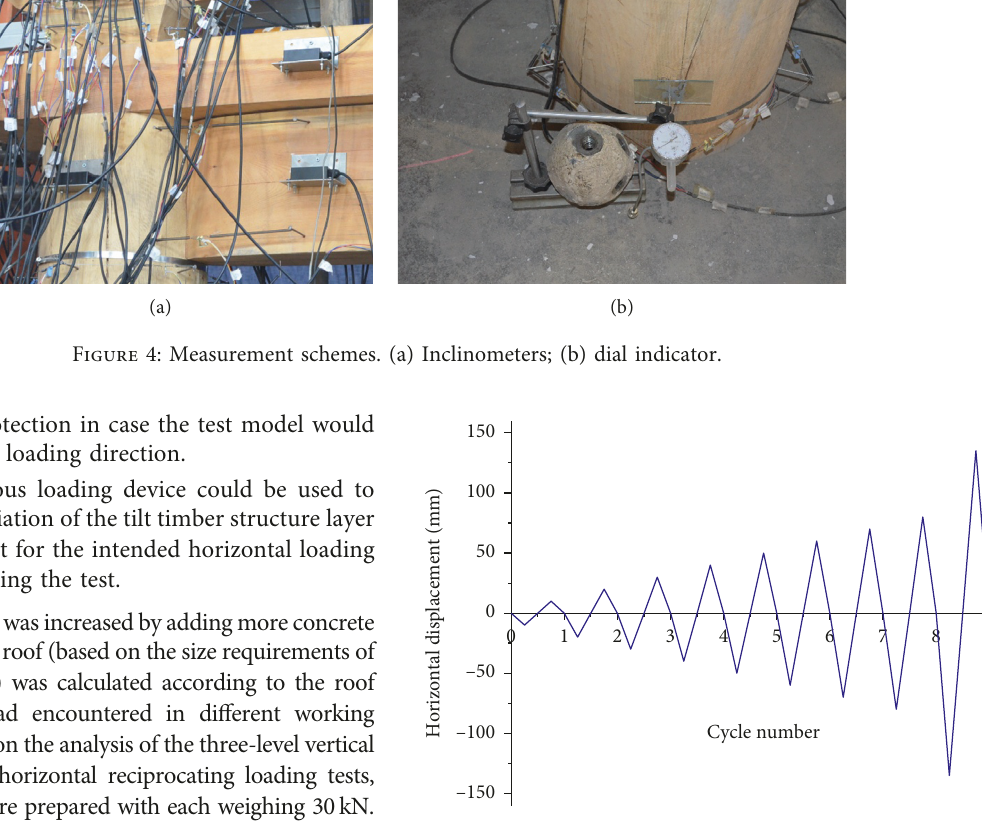
Figure 5: Loading